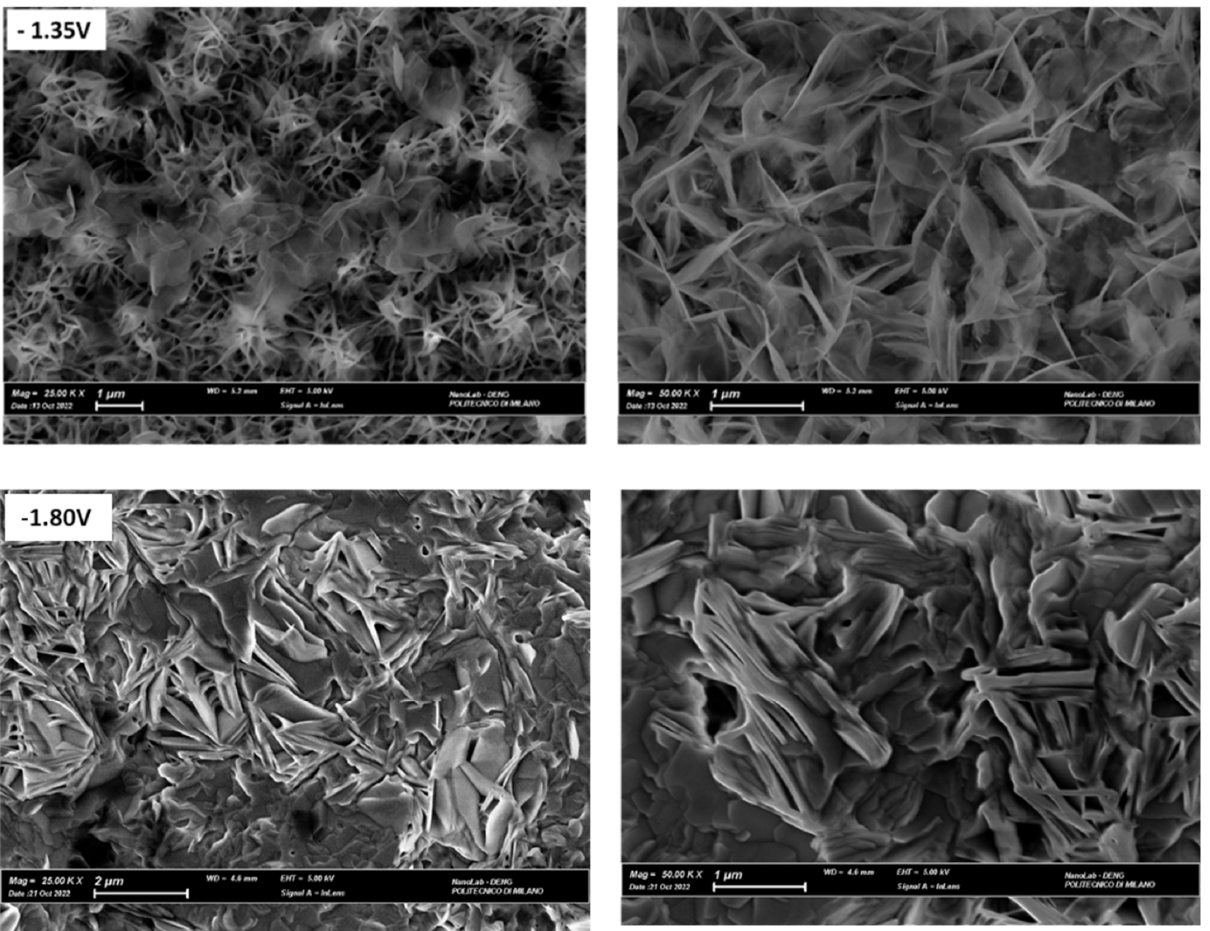
Figure 11. SEM images of Zn deposits were potentiostatically obtained on polycrystalline Zn at E = −1.35 and −1.80 V from 0.3 M ZnSO 4 in DES ChEG. Electrodeposition time: 900 s.